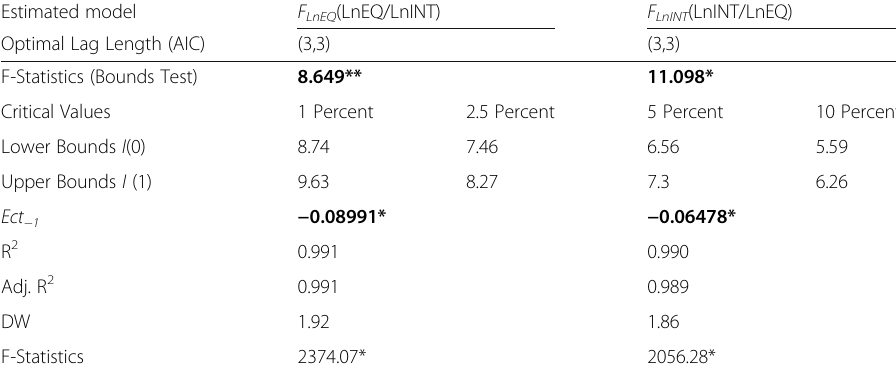
Table 2 Results of the bounds test of cointegration and Ect − 1 term from short-run dynamics Estimated